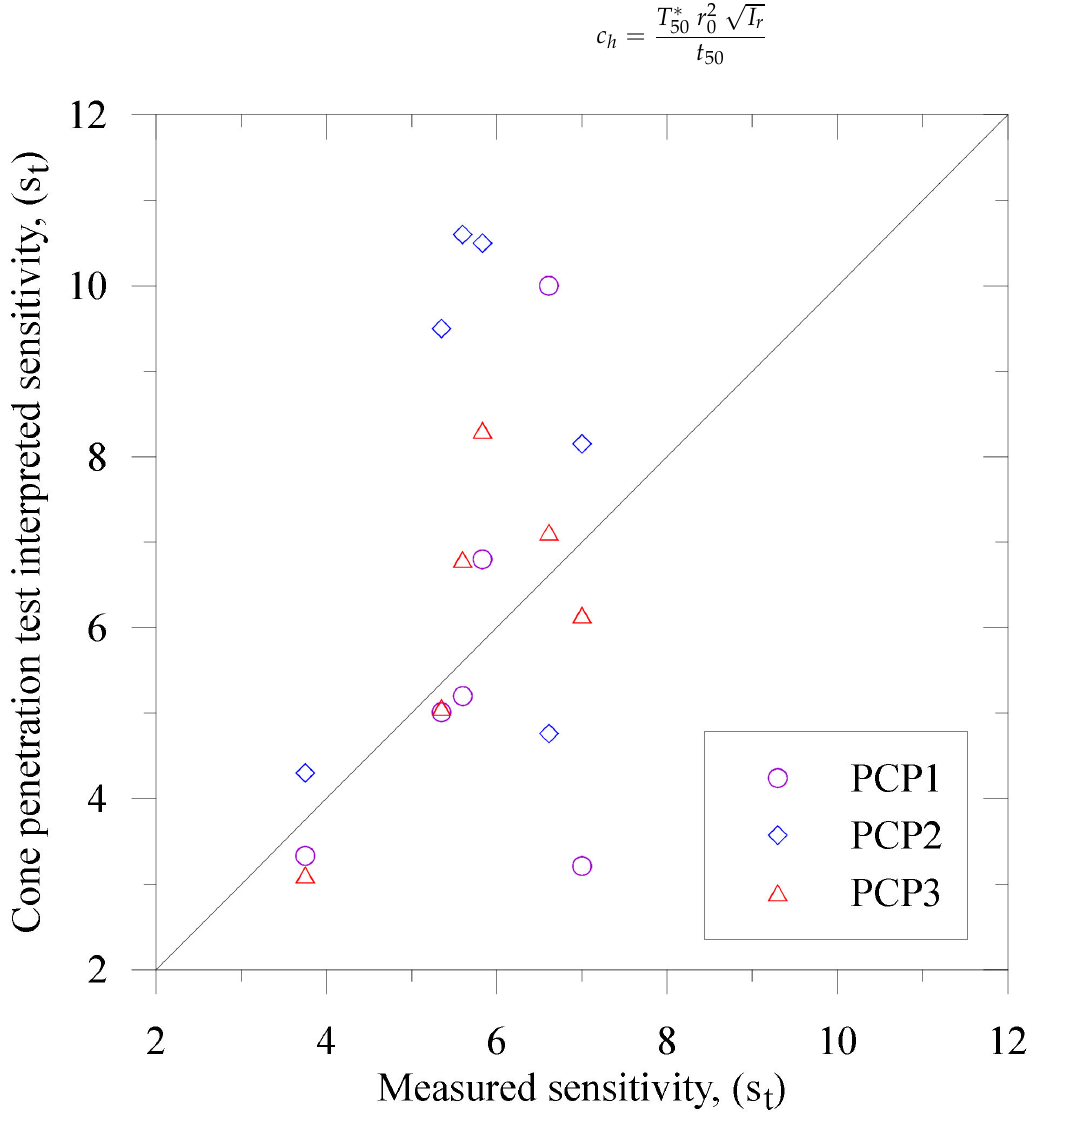
Figure 11. Measured and predicted sensitivity relation of the embankment’s foundation